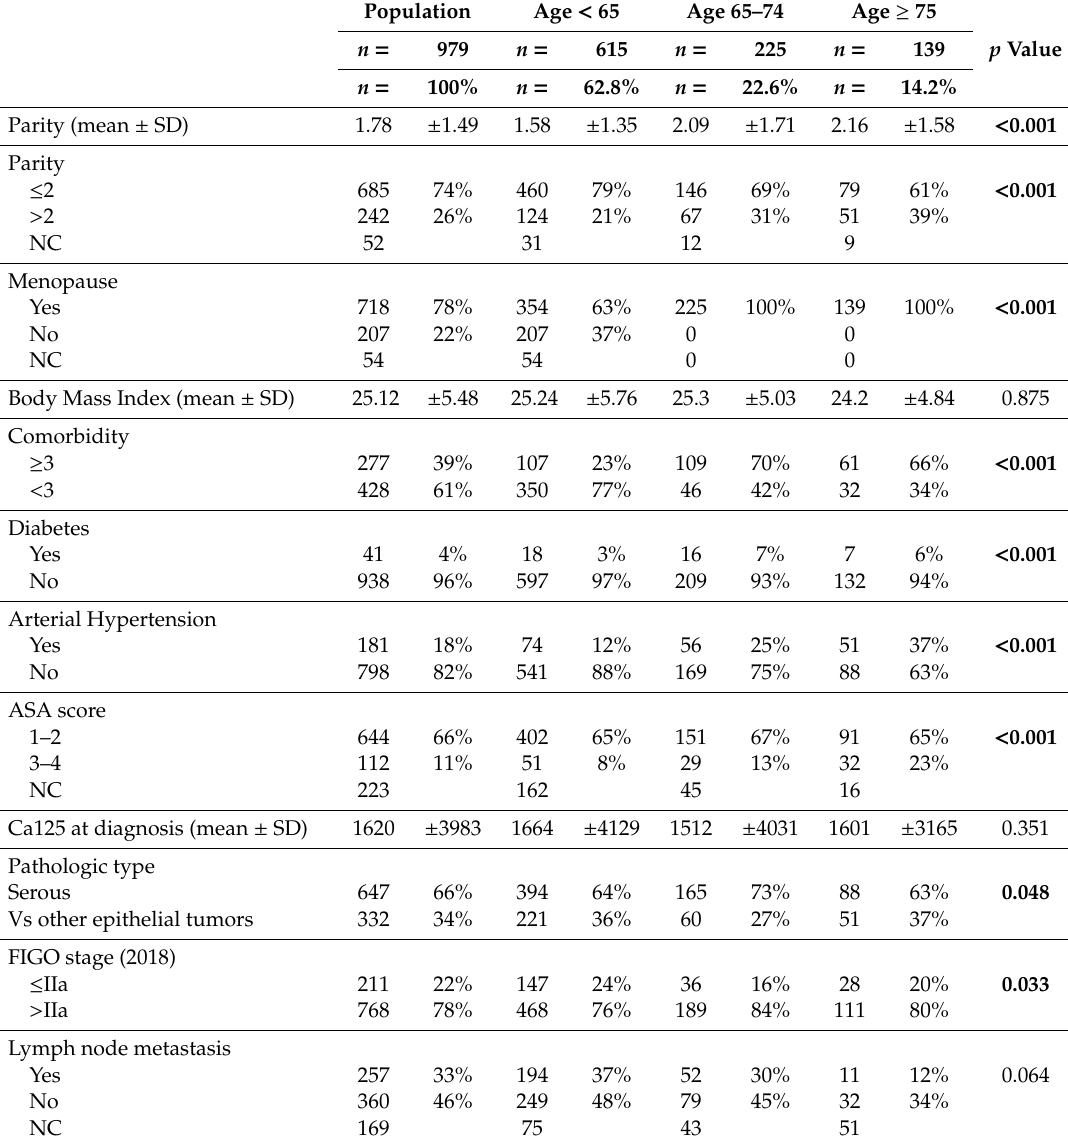
Table 1. Patient and Tumor Characteristics.